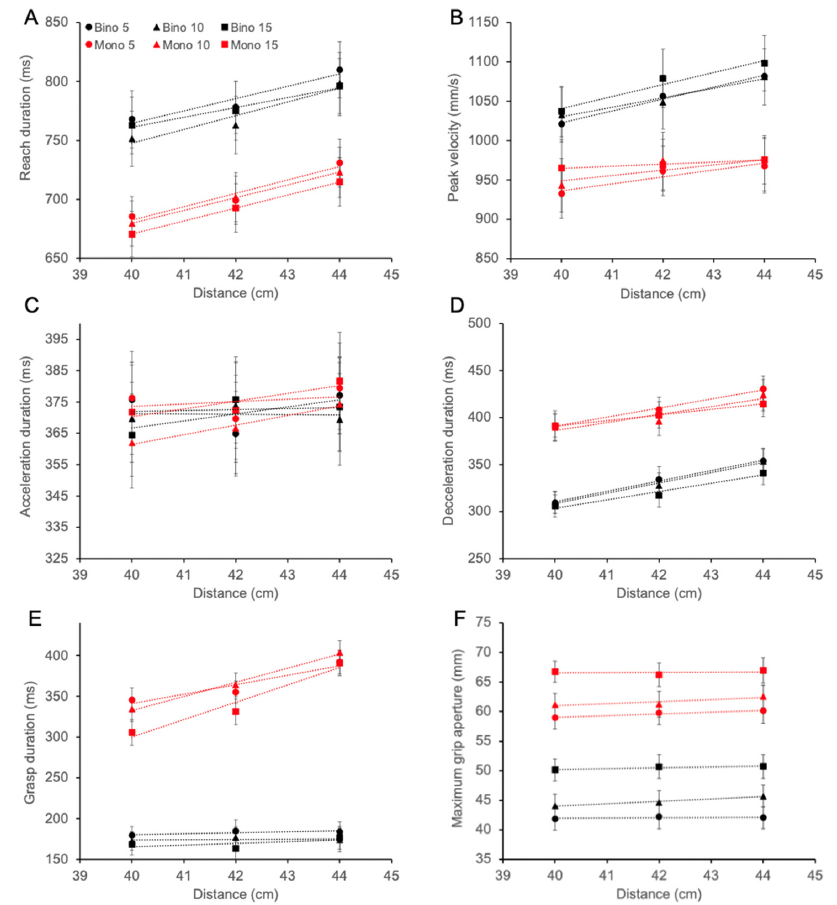
Figure 5. Mean kinematics obtained at the 3 viewing distances during binocular (black) and monoc- ular (red) viewing: reach duration ( A ); peak velocity ( B ); acceleration duration ( C ); deceleration duration ( D ); grasp duration ( E ); maximum grip aperture ( F ). The lines are fitted using a linear regression. Error bars show ± 1 standard error. Different symbols indicate object’s size (circle: 5 mm cylinder; diamond: 10 mm cylinder; square: 15 mm